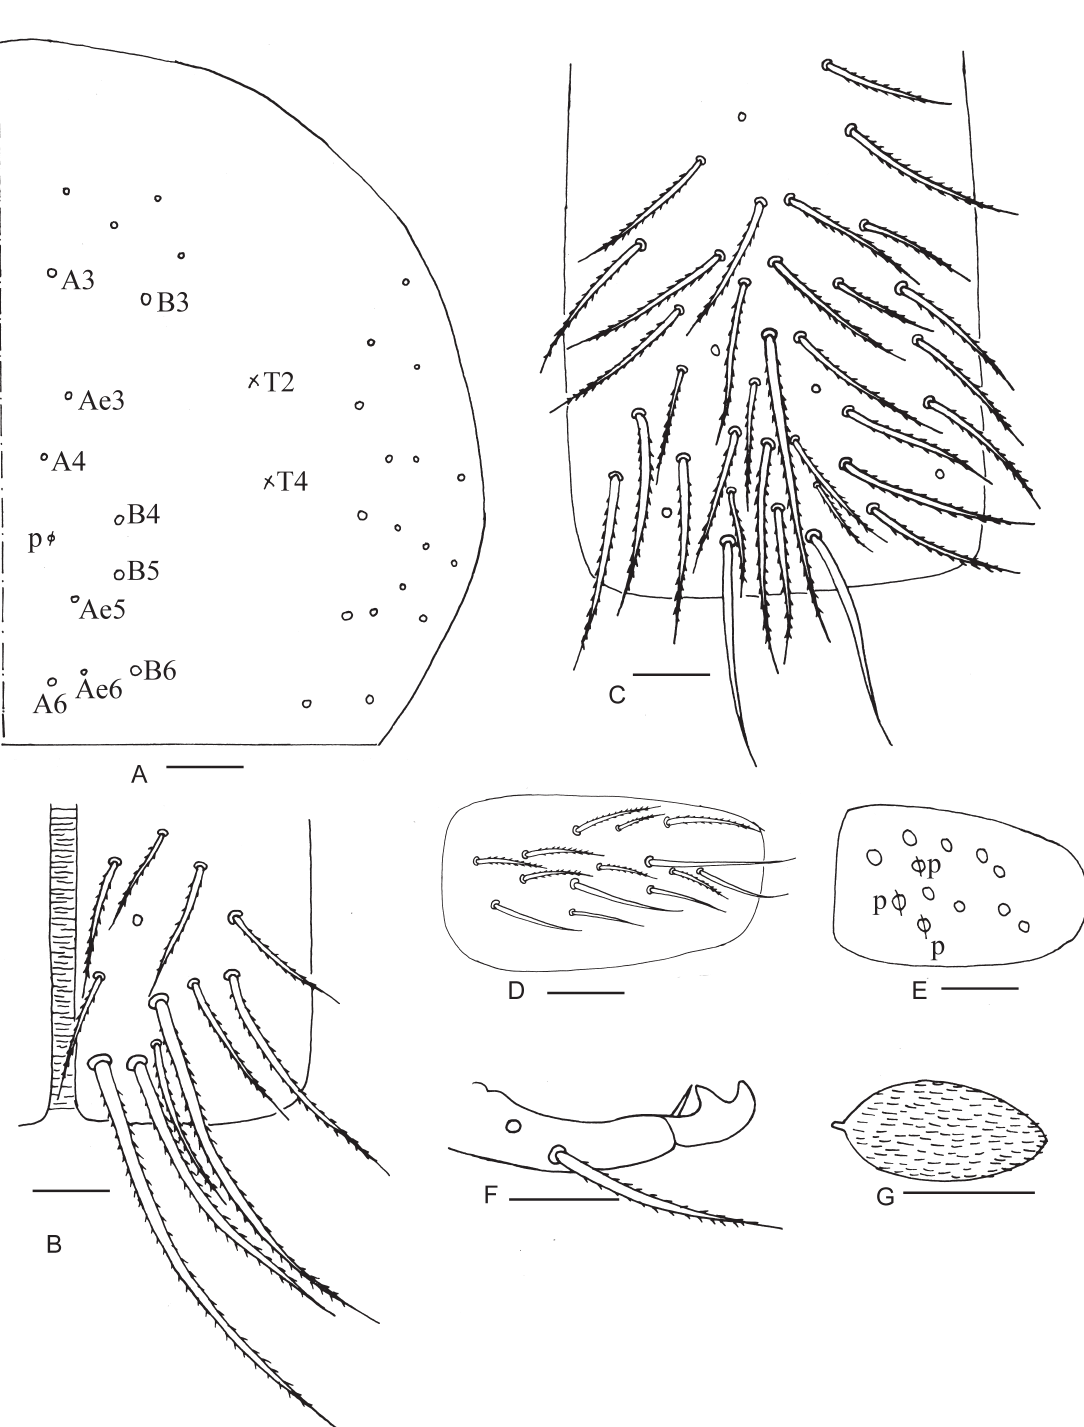
Fig. 3. Willowsia baoshanensis sp. nov. A . Chaetotaxy of Abd. IV. B . Anterior face of ventral tube. C . Posterior face of ventral tube. D . Lateral flap of ventral tube. E . Plaque of manubrium. F . Distal part of dens and mucro. G . Scale. Scale bars: A = 50 μm; B–G = 15